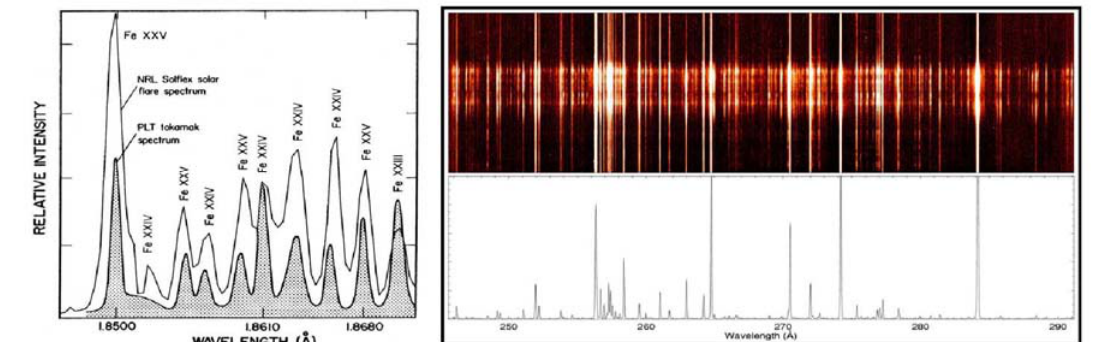
Figure 6. Left: Iron line spectrum of a solar flare recorded by X-ray spectrometers on the US Department of Defense (DoD) Space Test Program (STP) P78-1 spacecraft compared with a tokamak spectrum from the Princeton Large Torus. Right: The extreme-ultraviolet spectrum of solar quiet and active regions obtained by the EIS instrument on the Hinode